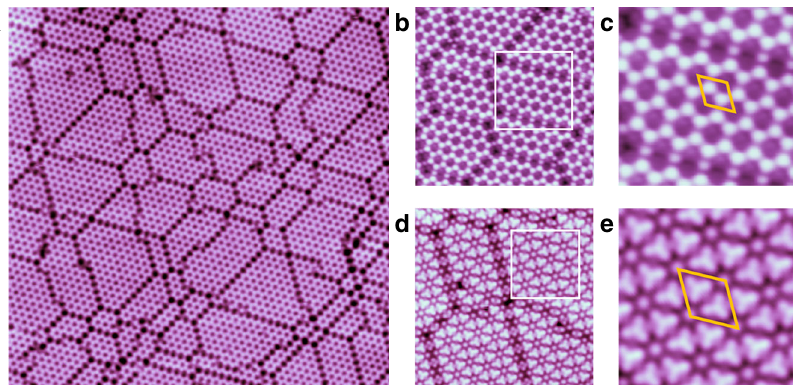
Fig. 3 STM images of γ phase on Cu(111) at 5 K. a STM image of γ phase of 2D CO at 5 K. b High-resolution STM image of γ phase obtained by normal W tip. d High-resolution STM image of γ phase obtained by CO-decorated W tip. c , e STM image of areas enlarged from that marked by rectangles in b and d , respectively. The rhombuses represent units cell of γ phase with a period of 1.0 nm, corresponding to 4 × 4 superlattice with respect to Cu(111). The sizes of images are: a 50.0 × 50.0 nm; b 14.8 × 14.8 nm; c 6.0 × 6.0 nm; d 10.0 × 10.0 nm; e 3.8 × 3.8 nm. The scanning parameters are: a V tip = − 0.8 V, I = 210 pA. b , d V tip = − 1.0 V, I = 286 pA